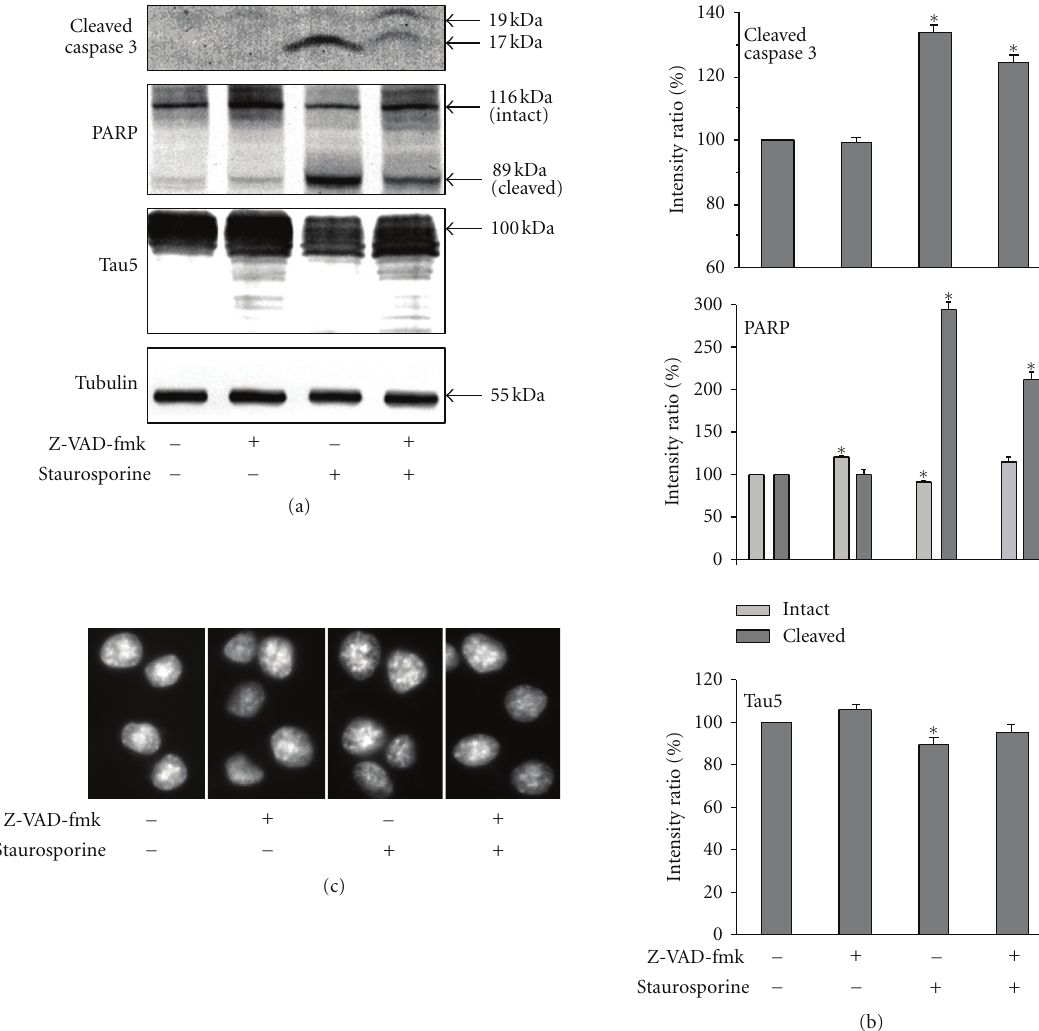
Figure 1: Pharmacological manipulation of caspase activity. (a) presents immunoblots of lysates from cells treated with Z-VAD-fmk, staurosporine, or both, along with untreated controls, probed with antibodies directed against cleaved caspase-3, PARP, tau, and tubulin (as a loading control) as indicated. The accompanying graphs (b) present the mean intensity ratio ( ± SEM) normalized to untreated controls from 3 immunoblots. Note increased levels activated caspase-3 and PARP cleavage, and reduced levels of tau following staurosporine treatment. Note that Z-VAD-FMK did not reduce steady-state levels of cleaved caspase-3, cleaved PARP, or tau but increased intact PARP (21%), suggesting the presence of ongoing caspase activity and PARP cleavage in these cells prior to treatment. Co-treatment with Z-VDA-fmk attenuated staurosporine-induced caspase activity, PARP, and tau cleavage. The percentage changes were quantified by densitometric analyses of immunoblots. An asterisk indicates statistical significance when compared to untreated controls ( P < 0 . 05, Student’s t -test). (c) presents representative images of DAPI-stained cells. Note presence of healthy, nonapoptotic nuclei, indicating that incubation with staurosporine for 4 hours did not induce